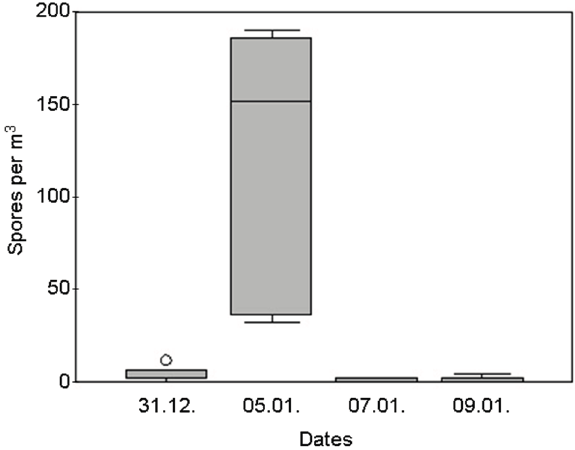
Figure 3. In-house Aspergillus spore concentration before, during (5 January) and after removal of the